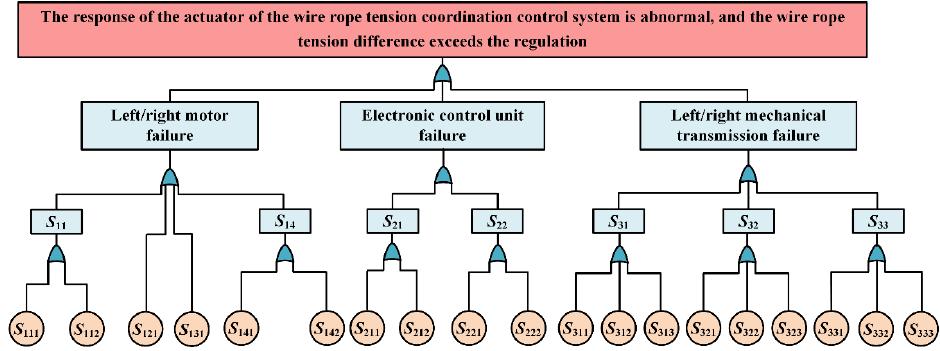
Figure 3. Fault Tree of Electromechanical Actuators in Tension Coordination Control System. Table 1. Electromechanical Actuator Failure Event and the Corresponding ID.